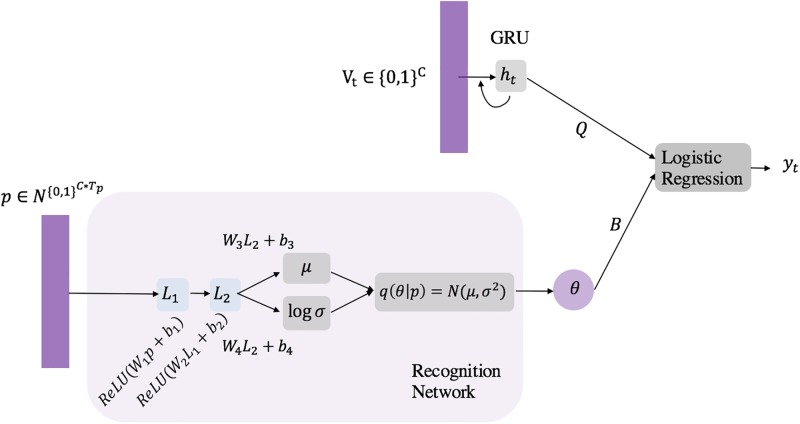
The CONTENT model.